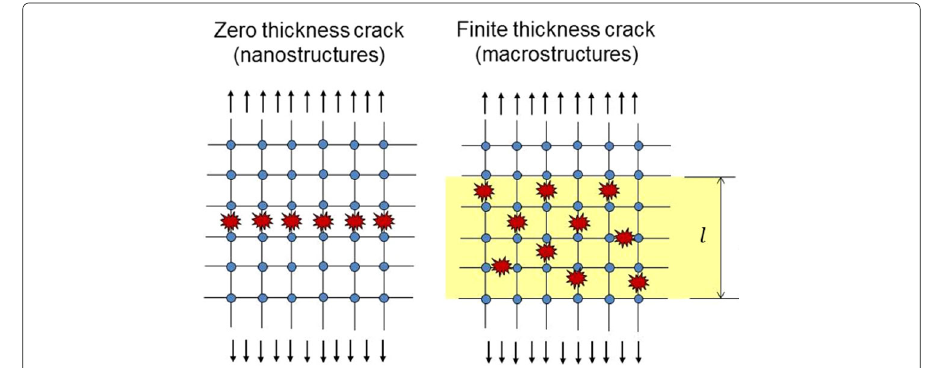
Fig. 1 Schematic drawing of cracks with zero or finite